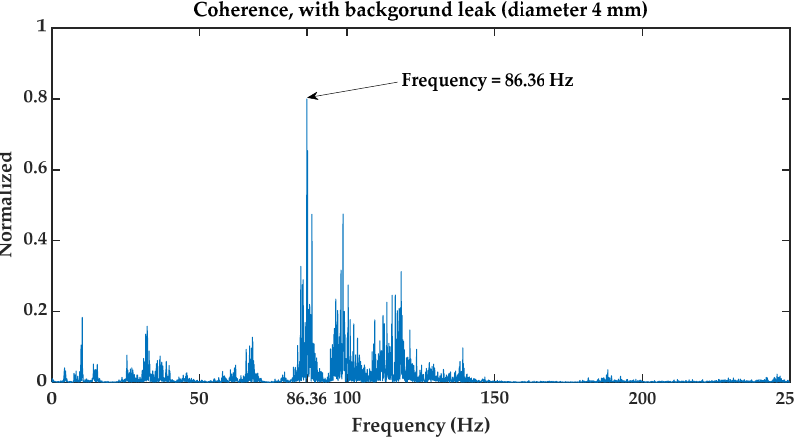
Figure 19. 𝒯 (cid:3032) cross-spectral density, with background leak ( 4 mm in diameter) and flow rate 125.0 mL/s .